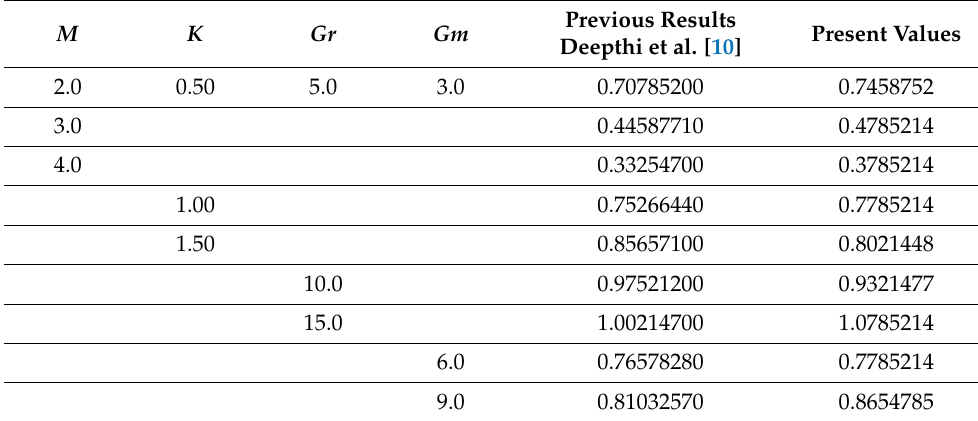
Table 4. The findings for the primary velocity compared and